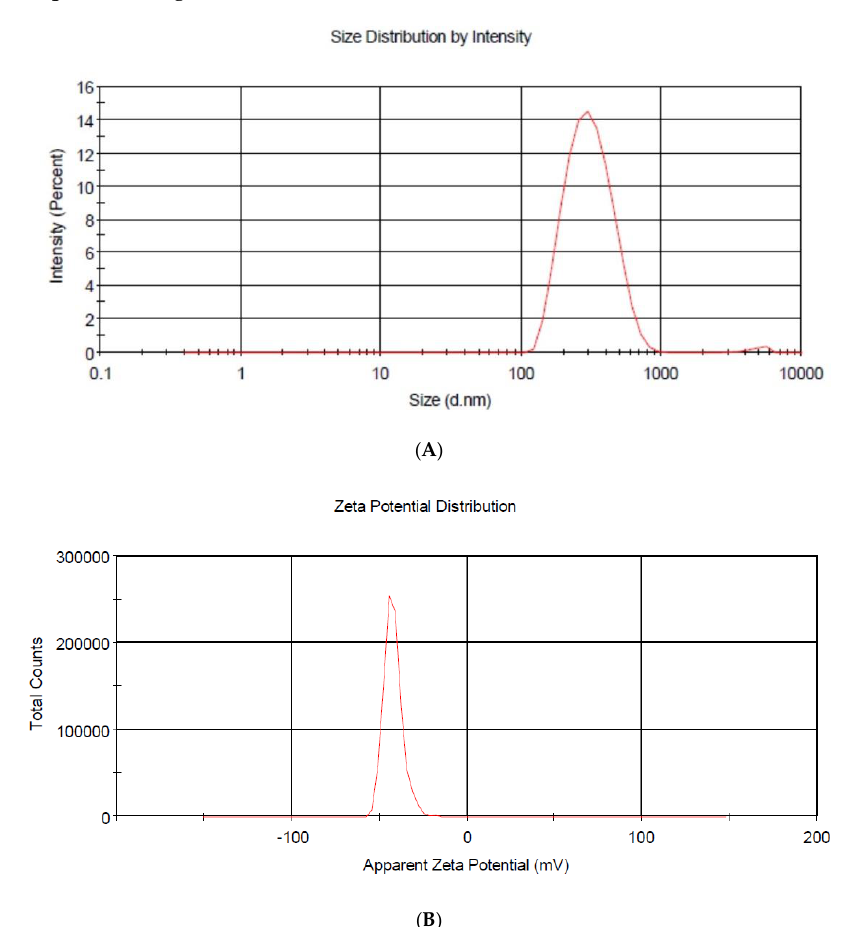
Figure 4. Particle size distribution ( A ) and zeta potential of NP-ZN-MSZ ( B ).